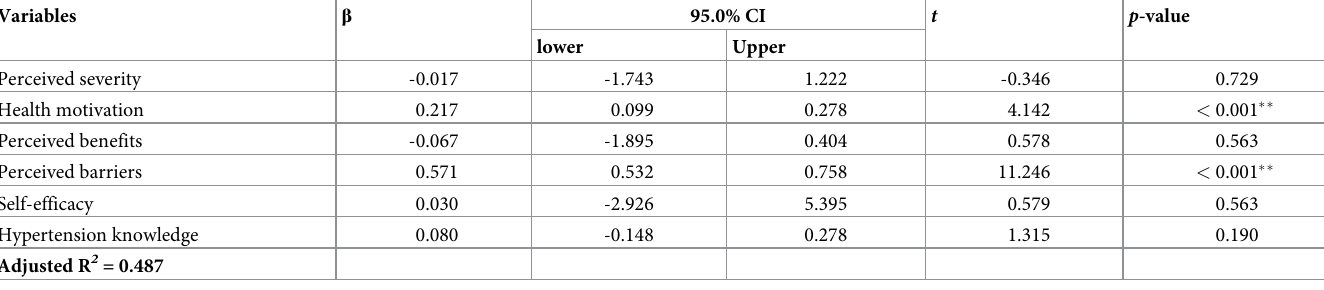
Table 3. R socio-demographic factors, hypertension knowledge, health belief model constructs, and self-care behaviour. Variables β 95.0%